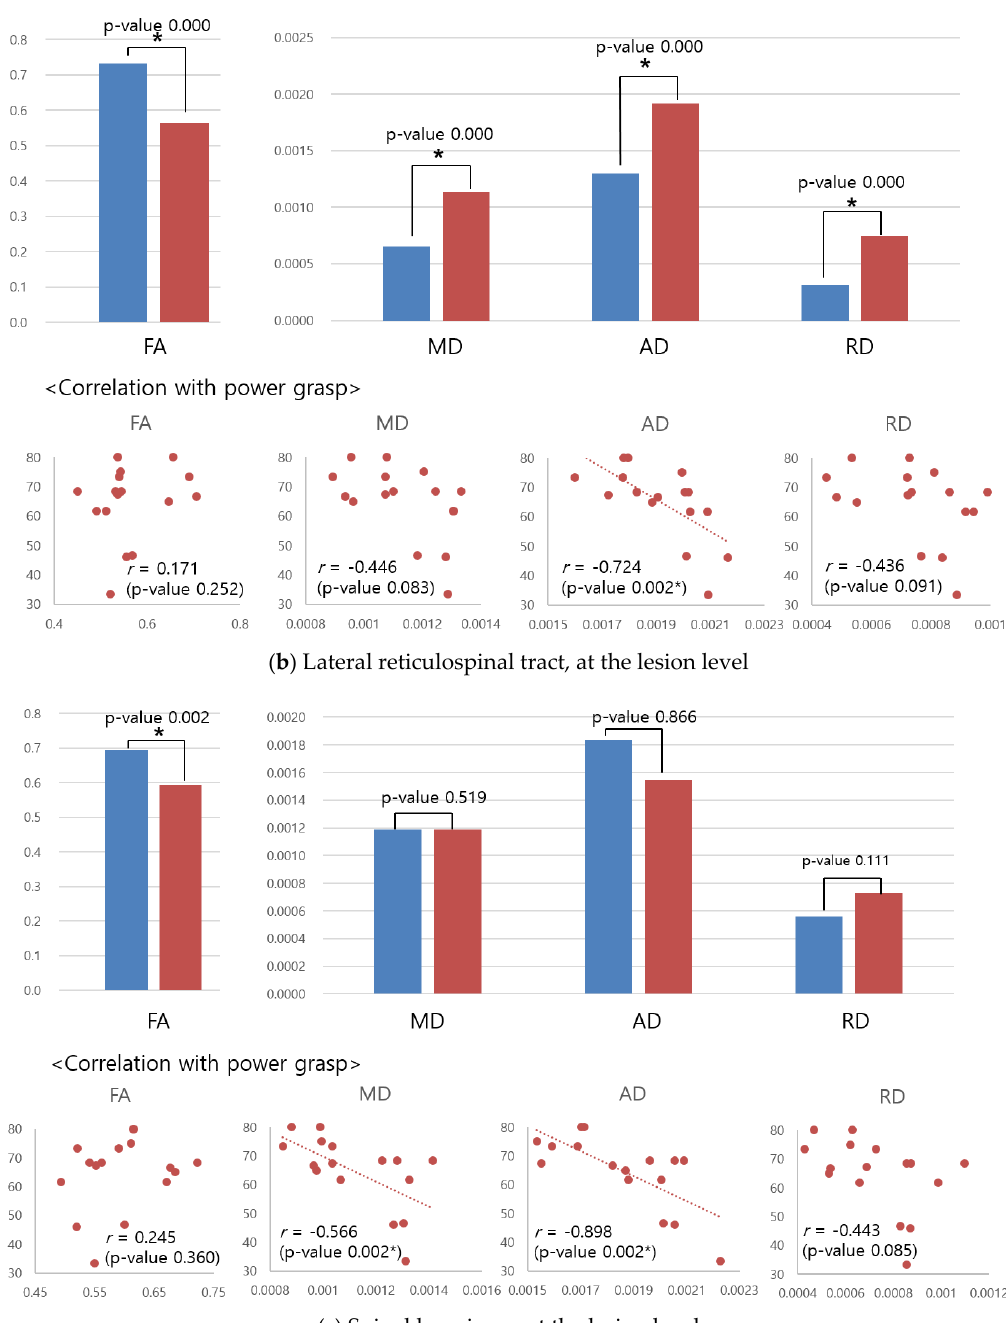
Figure 4. Group difference and correlation between MR parameters and motor items at rubrospinal